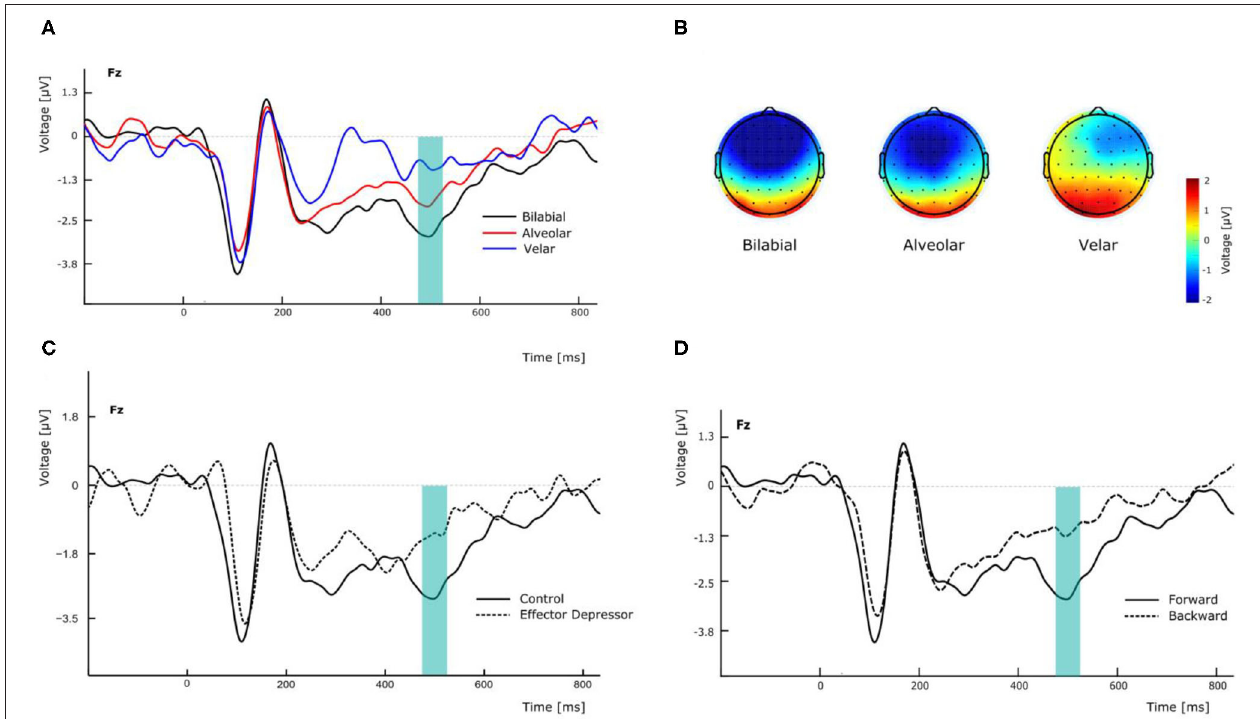
FIGURE 2 | Effects of experimental manipulation on N400 component. (A) Effect of the different PoA of forward syllables in electrode Fz. (B) Topographical maps of the N400 according the PoA at the peak amplitude latency (500ms). (C) Effect of effector depressor on the perception of forward bilabial syllables in electrode Fz. (D) Effect of forward versus backward syllables on the perception of bilabial syllables without effector depressor in electrode